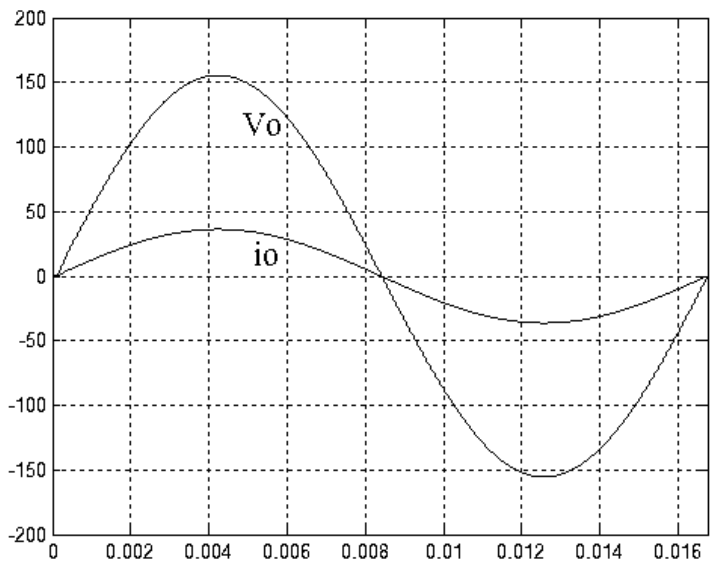
Figure 5. Simulation output waveforms against filter parameter variations obtained using the proposed approach.